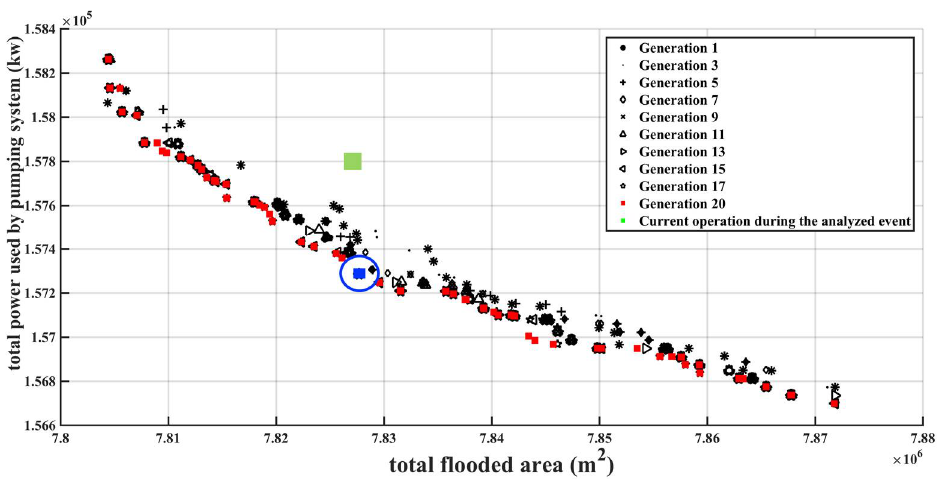
Figure 9. Pareto front obtained for the rainfall trend of the event that occurred in March 2011.